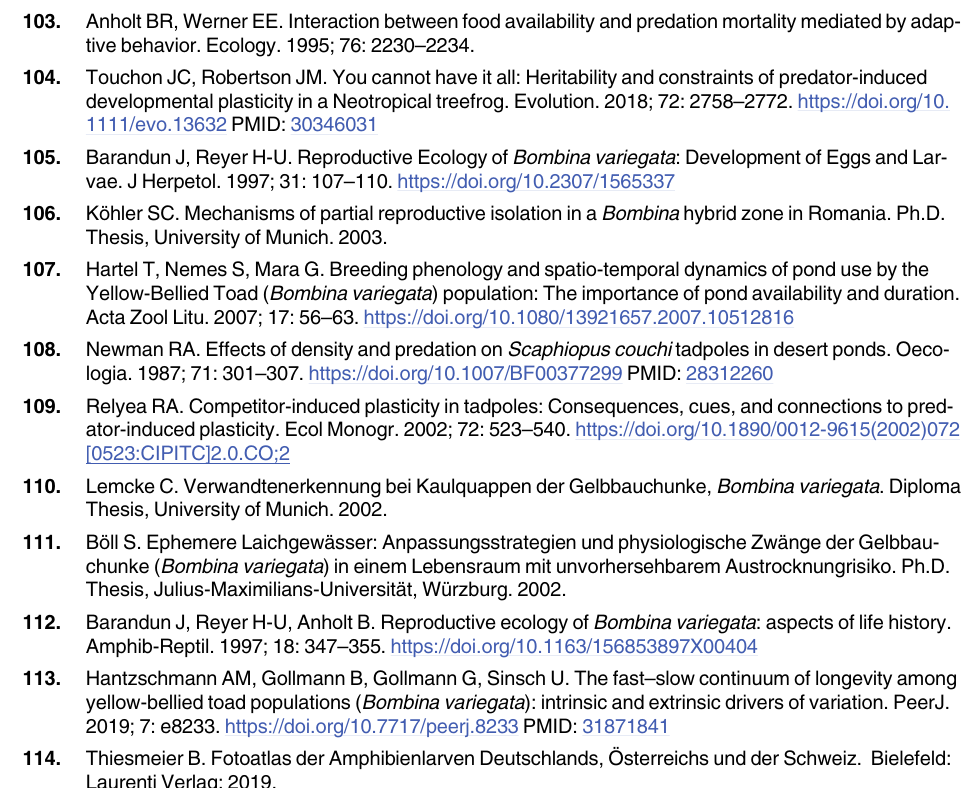
114. ThiesmeierB. Fotoatlas der AmphibienlarvenDeutschlands, O¨ sterreichs und der Schweiz. Bielefeld: LaurentiVerlag;